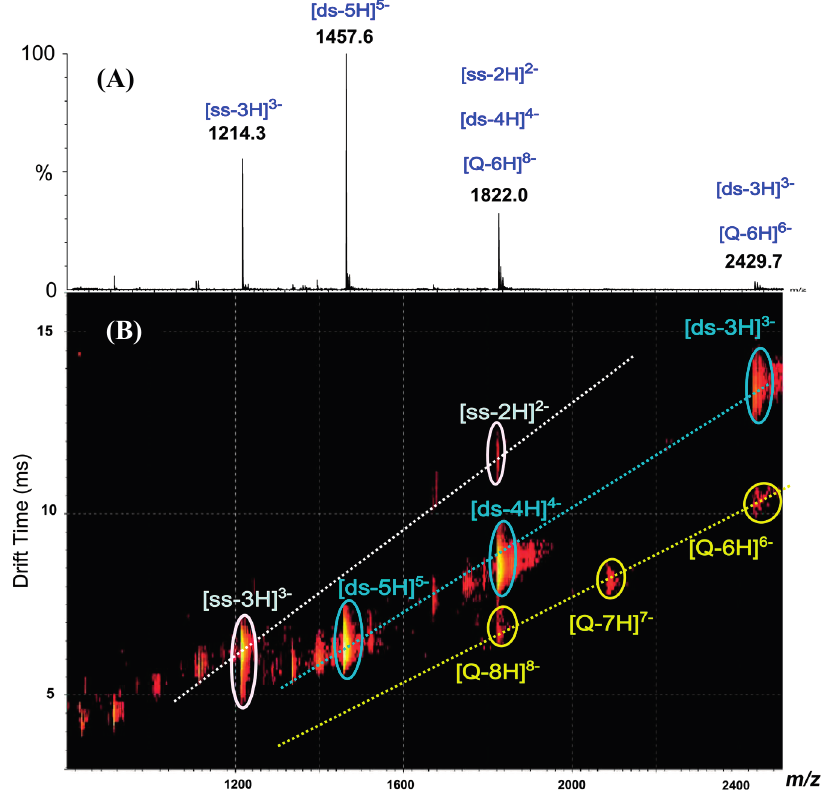
Figure 2. Negative-ion ESI mass spectrum ( A ) and IM-MS plot (drift time versus m/z ) ( B ) of DNA duplex